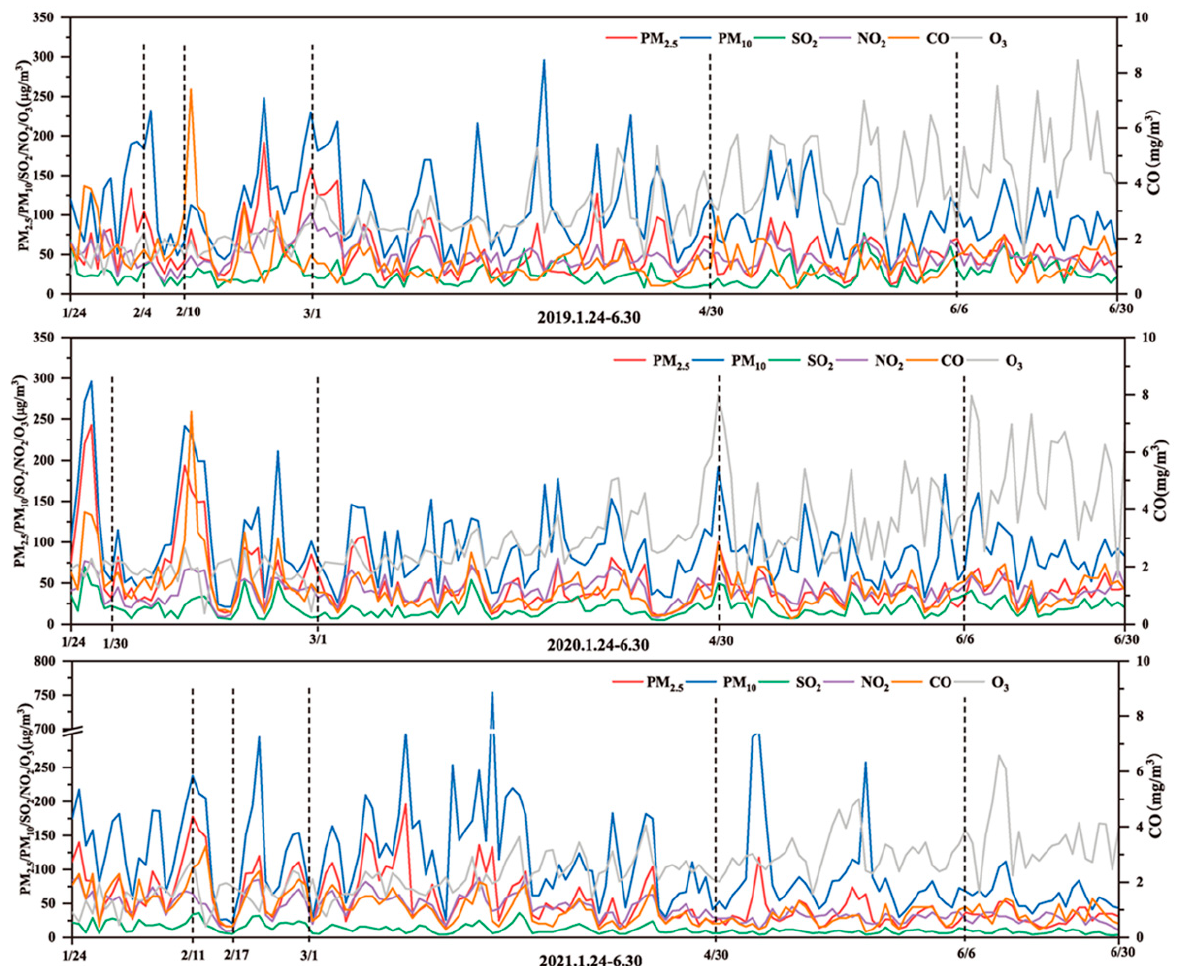
Figure 3. Variation in the daily average concentrations of pollutants from 24 January to 30 June for the 2019–2021 period.